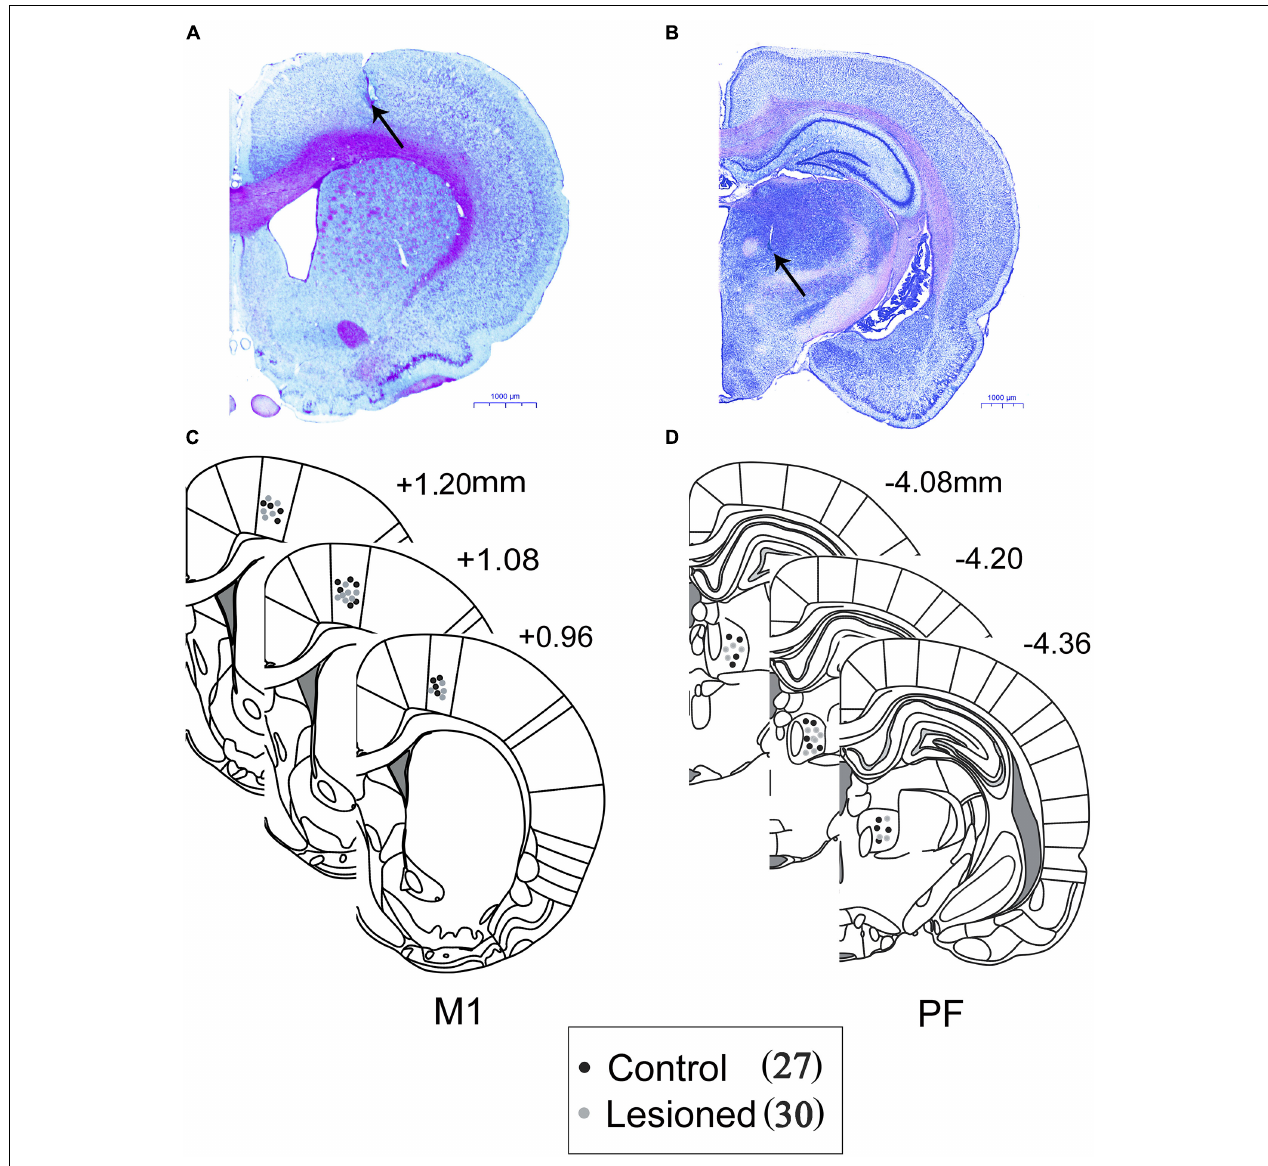
FIGURE 2 | Histological representative example of Nissl-stained coronal sections of rat brain, photographed demonstrating the recording electrodes in the (A) M1 and (B) PF. Locations of electrode tips as marked by electrolytic lesions are marked with black arrows. Scale bar = 1,000 µ m. Three schematic reconstructions in the (C) M1 and (D) PF of the three regions from the rat brain atlas of Paxinos and Watson represent the placements of electrodes in the DA-lesioned rats (gray circles) and control rats (black circles).